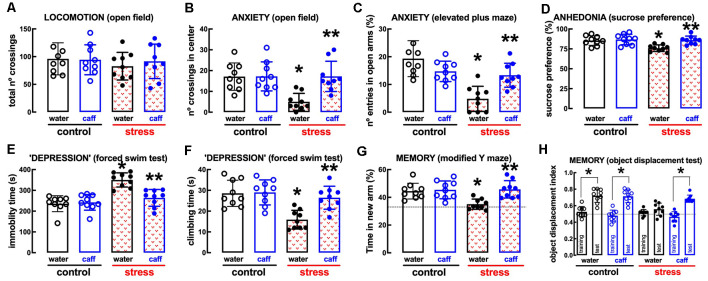
Male adult Wistar rats (8–10 weeks old) subject to a protocol of restraint stress (4 h/day) during 14 days display the expected features of depressed rats, which were prevented by the adenosine receptor antagonist caffeine (caff). Whereas caffeine consumption (0.3 g/L, po, beginning 3 days before the stress protocol and until the sacrifice of the animals; blue) was devoid of effects in non-stressed control rats (open bars), caffeine prevented all behavioral modifications of stressed rats (red checkered bars): without modification of locomotor activity as evaluated in the open field (A), caffeine prevented anxiety-like behavior as evaluated in the open field (B) and in the elevated plus-maze (C) tests, anhedonia as evaluated in the sucrose preference test (D), helpless-like behavior as evaluated by the forced-swimming test (E,F) and impaired memory performance as evaluated by a modified Y maze test (G) and an object-displacement test (H). Data are shown as mean ± SEM; n = 8–9 rats per group. *P < 0.05 vs. control-water, **P < 0.05 vs. stress-water using a Tukey’s multiple comparisons post hoc test after a two-way ANOVA.